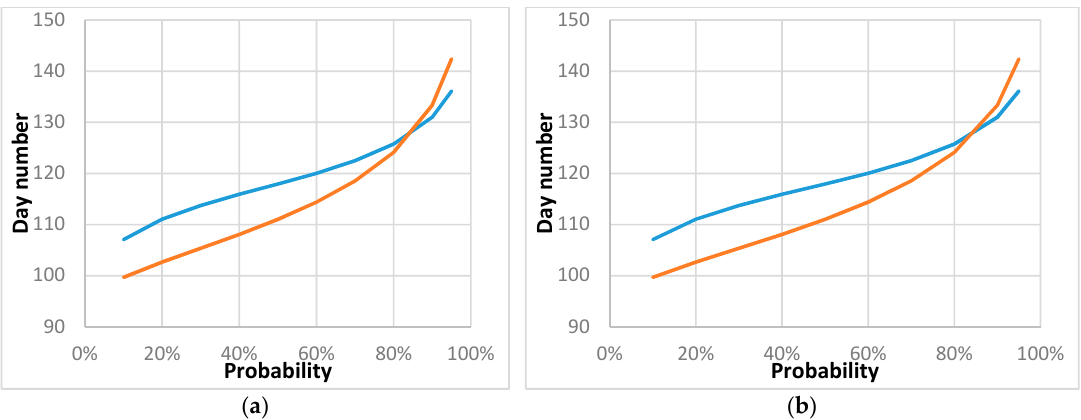
Figure 9. The probability curves of the last spring frost described by a calendar day number ( Tmin < 0 °C) in the period of 1961–1990 (blue line) and 1991–2020 (orange line). ( a ) Wielichowo, ( b ) Lublin.